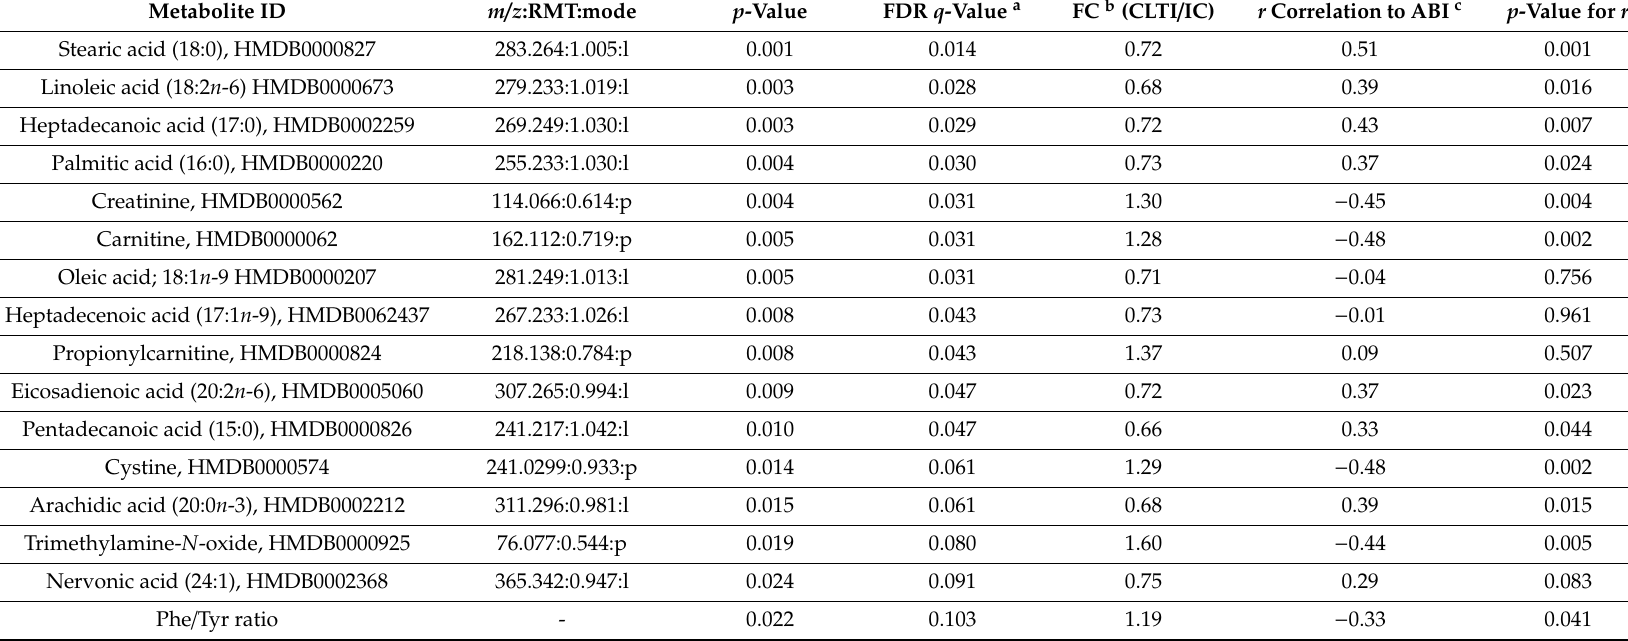
Table 3. Top-ranked serum metabolites comparing IC ( n = 20) to CLTI ( n = 18) using the Student’s t -test and their correlation to ABI. Metabolite